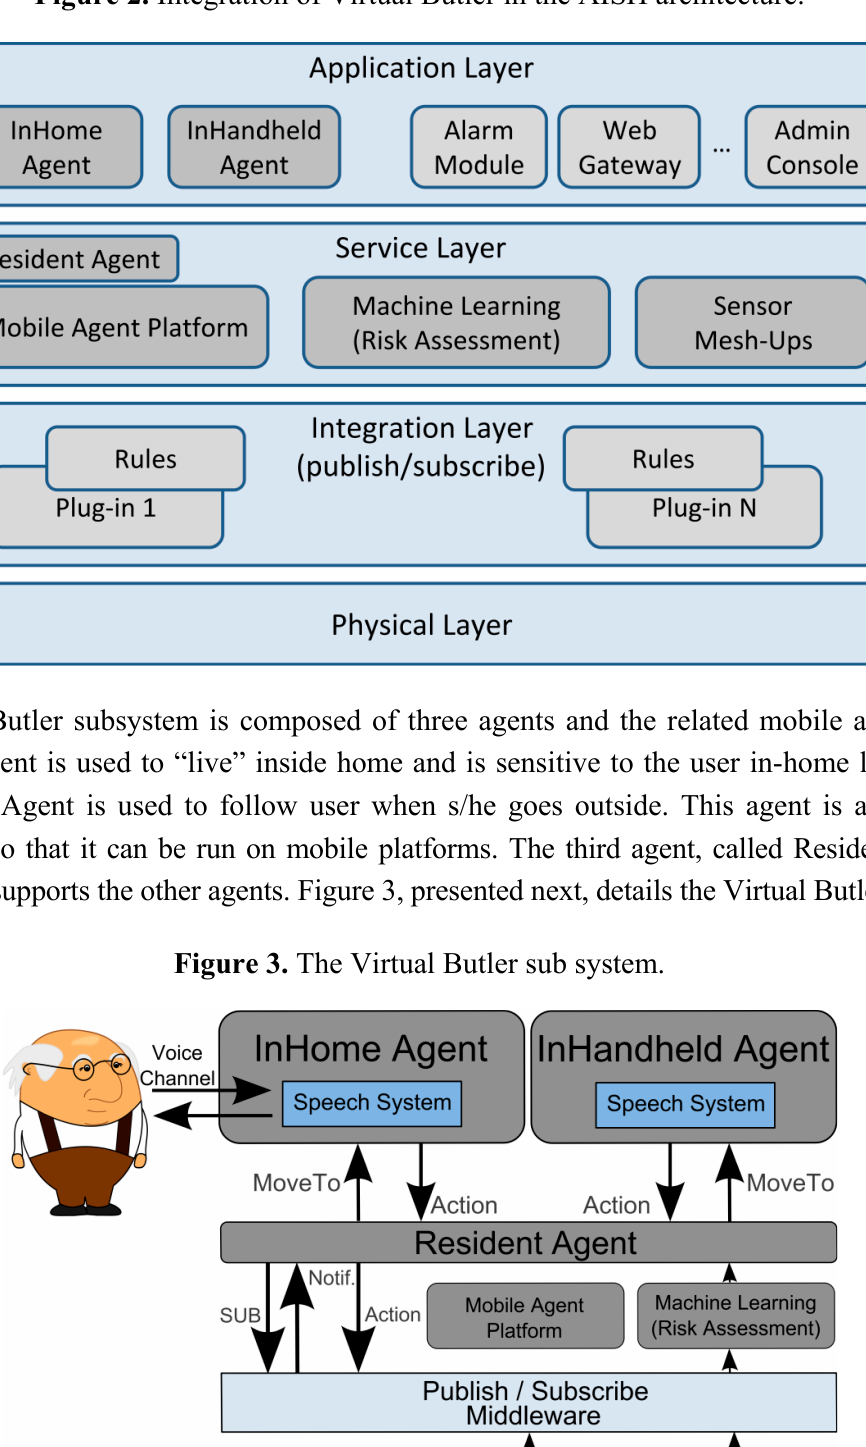
Figure 2. Integration of Virtual Butler in the AISH architecture.